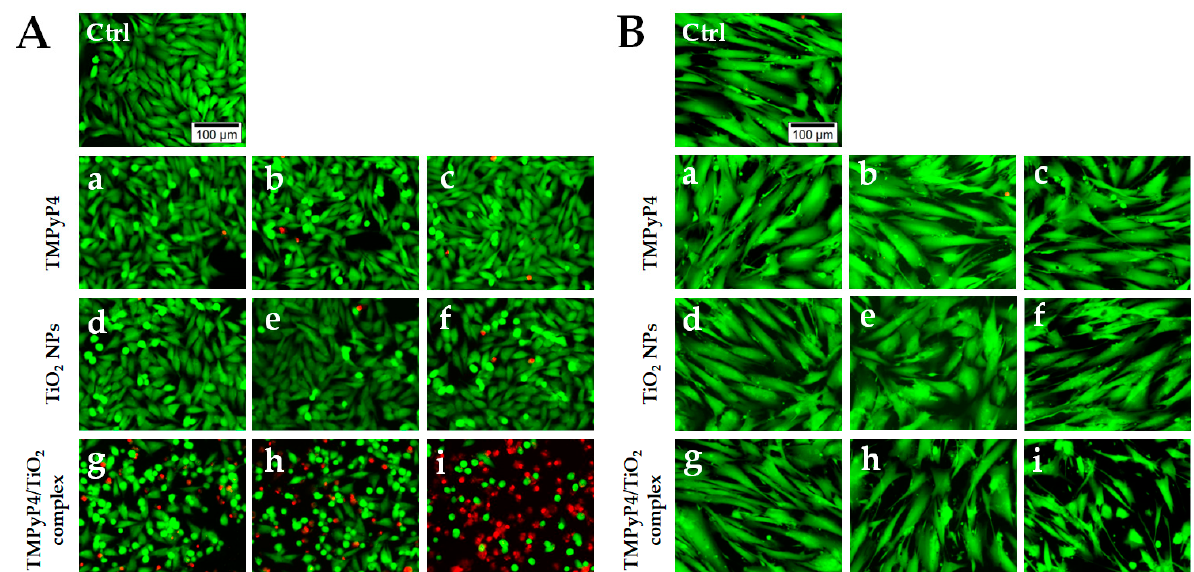
Figure 8. LIVE/DEAD staining on treated Mel-Juso ( A ) and CCD-1070Sk cells ( B ) after light irradiation for 7.5 min. Cells were treated with di ff erent concentrations of TMPyP4: 0.5 µg/mL (a), 0.75 µg/mL (b), and 1 µg/mL (c); TiO 2 NPs: 20 µg/mL (d), 30.7 µg/mL (e) and 40 µg/mL (f) and TMPyP4/TiO 2 complex: 0.5/20 µg/mL (g), 0.75/30.7 µg/mL (h), 1/40 µg/mL (i). Control cells (Ctrl) are non-treated, and light irradiated. Live cells are stained with calcein AM (green fluorescence), and dead cells with ethidium homodimer (red fluorescence). The scale bar is the same for all images and is 100 µm.